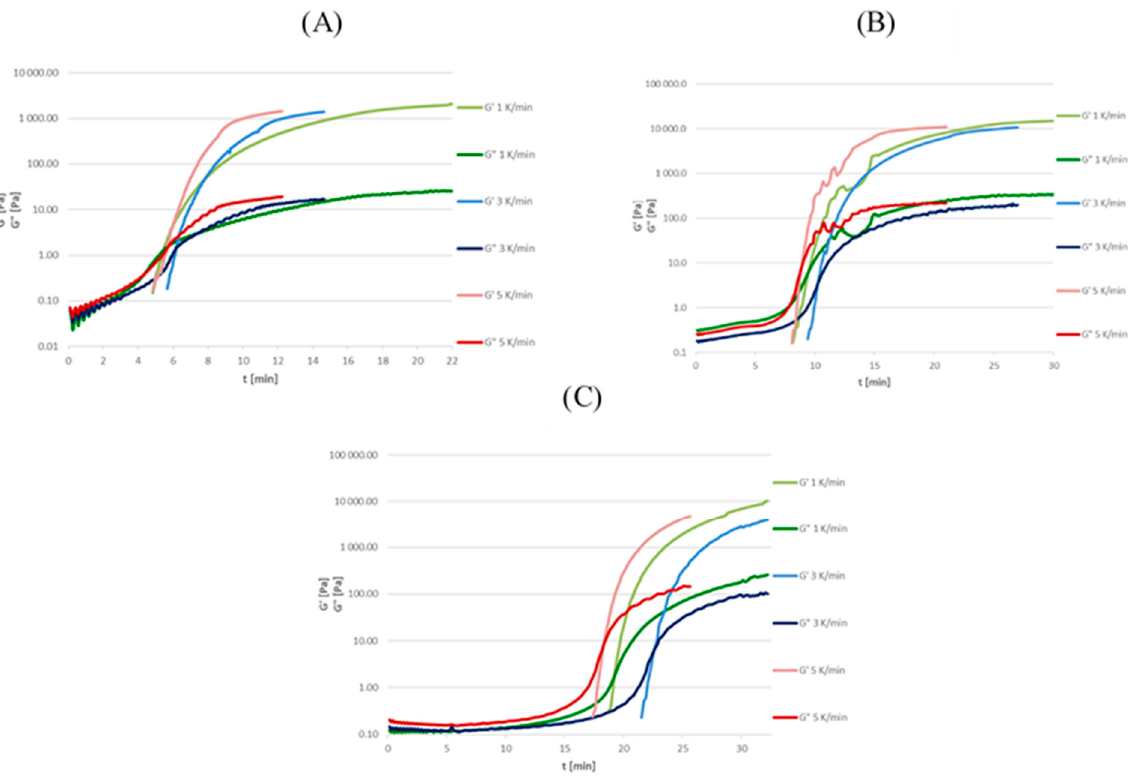
Figure 2. Gelatinization curves of a gelatin solution with different concentrations and cooling rates. Gelatin concentration: (A) - 4%, (B) - 8% and (C) - 12%